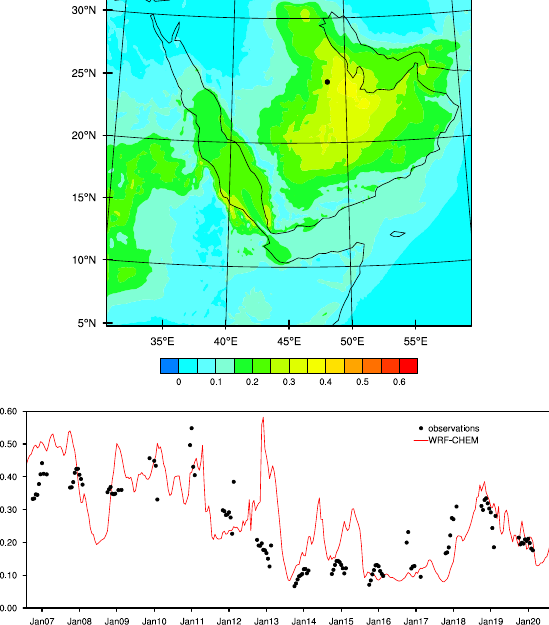
Fig. 7. Mean daytime (08:00–14:00UTC) spatial distributions of the simulated AOD at 600nm averaged over the simulation period (upper panel). The black dot in the upper panel indicates the loca- tion of the AERONET Solar Village site. The lower panel shows the time series of the observed and simulated AOD at